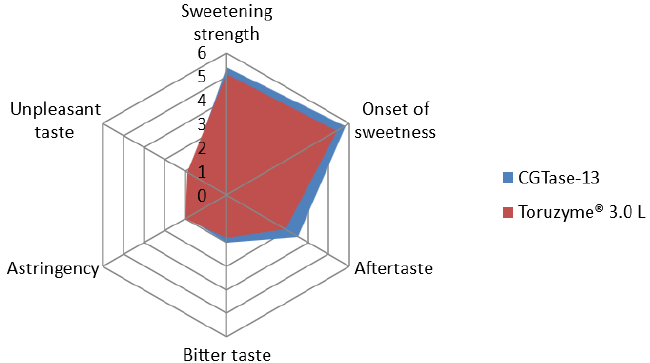
Figure 6. Spider-graph of sensory testing results (CGTase-13 and Toruzyme ® 3.0 L) .